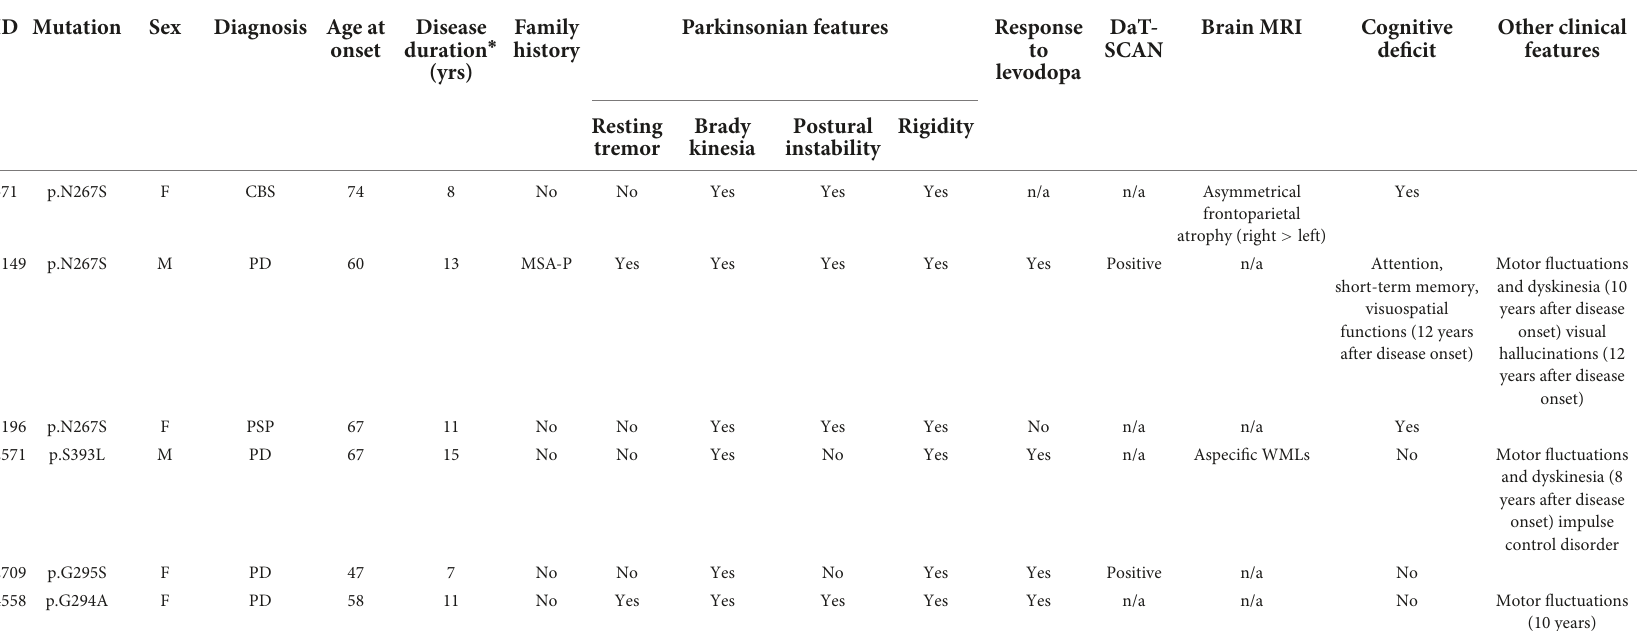
TABLE 2 Demographic and clinical characteristics of patients harboring TARDBP mutation in the study cohort.